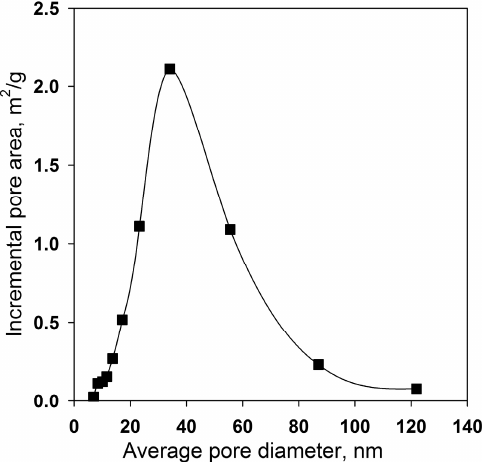
Figure 4. Pore size distribution calculated by BJH method.